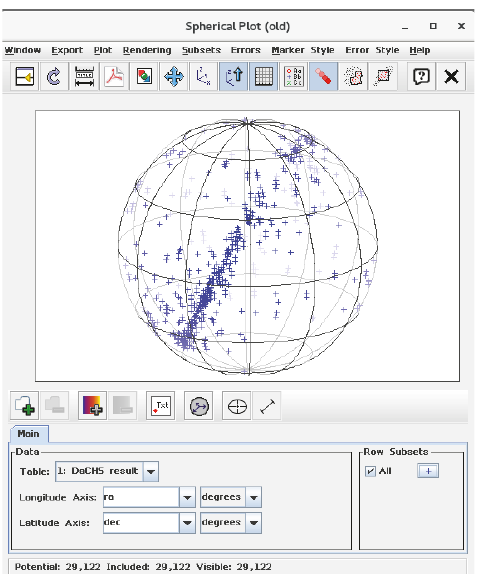
Figure 7: TOPCAT visualization